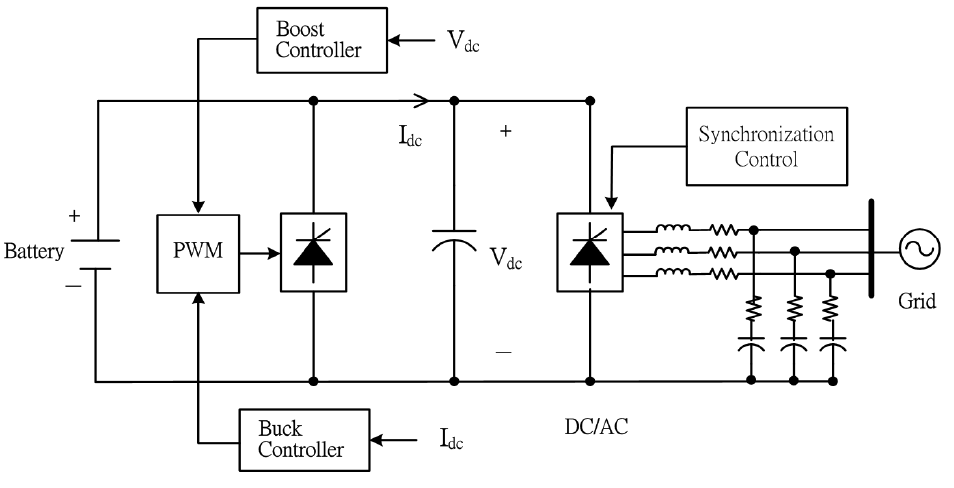
Figure A3. Control of discharge from energy storage